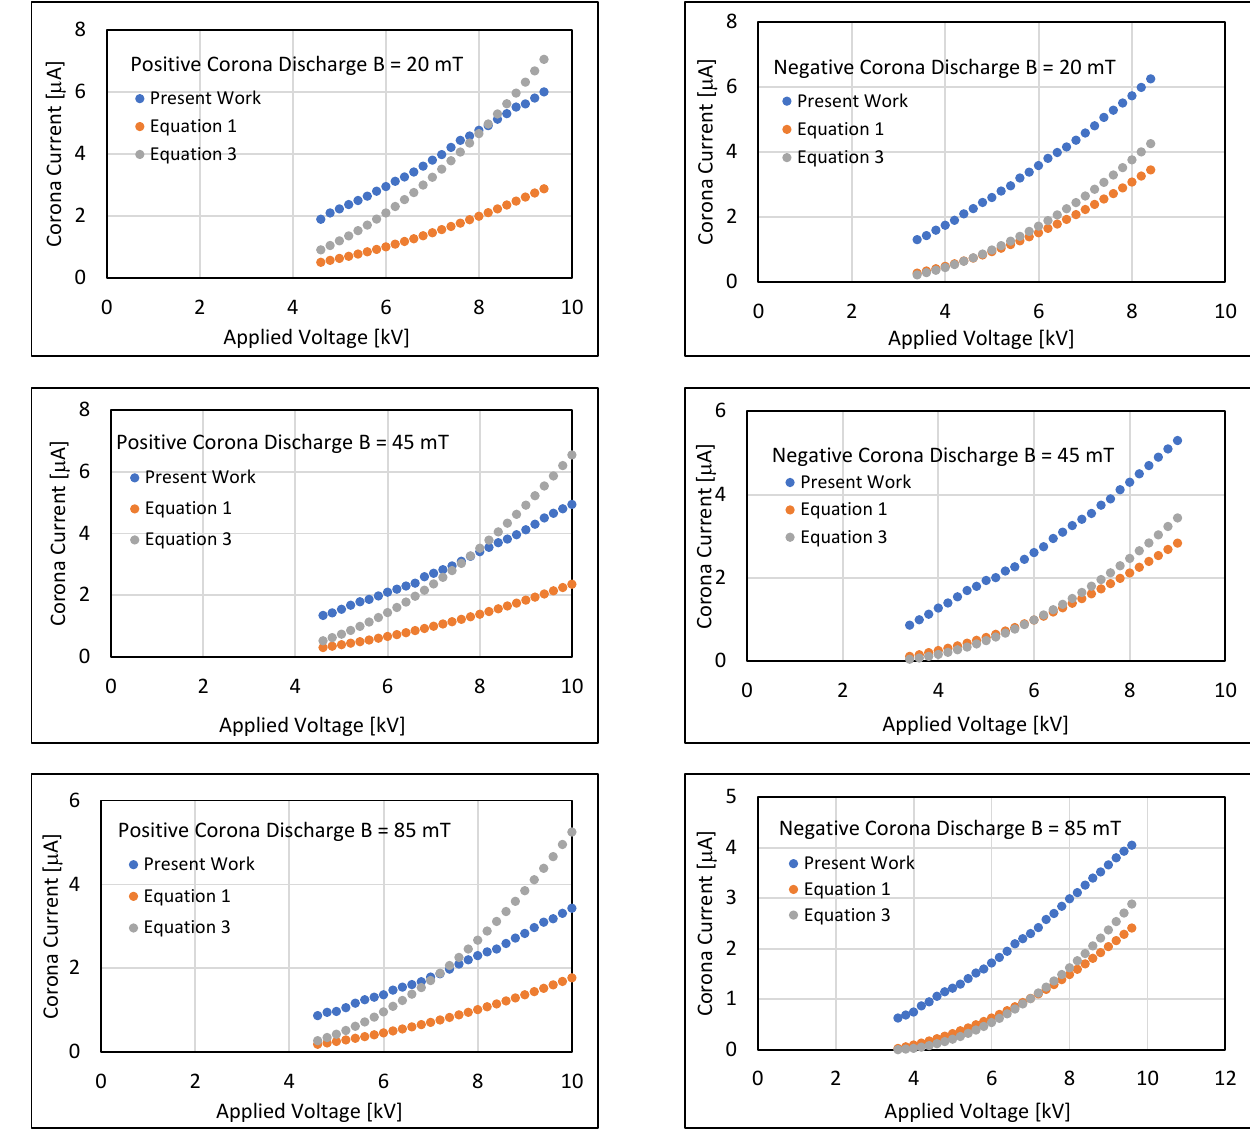
Figure 17. Comparison between the present study and empirical formulae proposed in Equations (1) and (3). The agreement of the present study was more acceptable with Equation (1) in positive corona, while in negative corona, the compatibility of the present study was almost the same with both Equations (1) and (3). In negative corona, the current-voltage curves were found to converge more with an increasing magnetic field, and this convergence was observed at B = 85 mT. However, the increase in the transverse magnetic field is accompanied by a decrease in exponent n, which in turn excludes the agreement between the present study with Equation (3). It is believed that the contribution of the transverse magnetic field in wire-cylinder coronas for both discharge polarities enhanced some properties such as per-breakdown, but in general it restricts the operating conditions in such a manner that decreased the corona current through a reduction in the electric field.